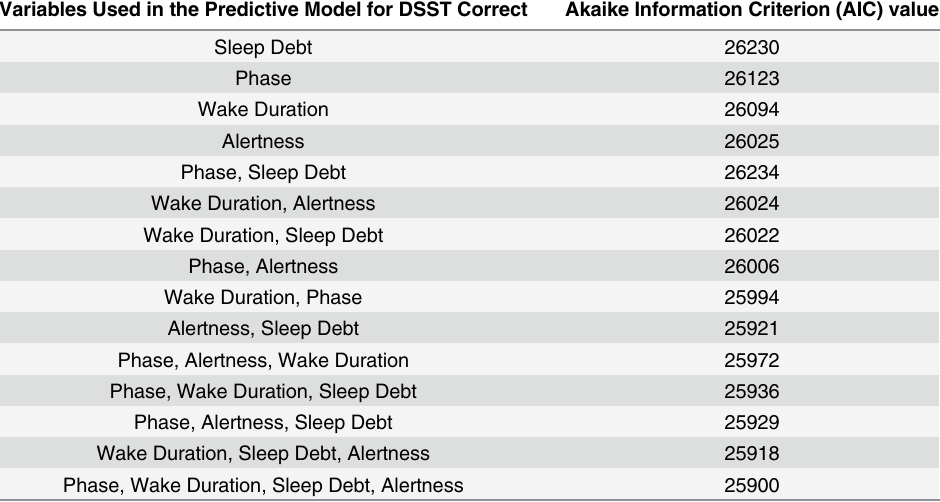
Table 4. Table of Akaike Information Criterion Values (AIC) for different predictive models of DSST. Variables Used in the Predictive Model for DSST